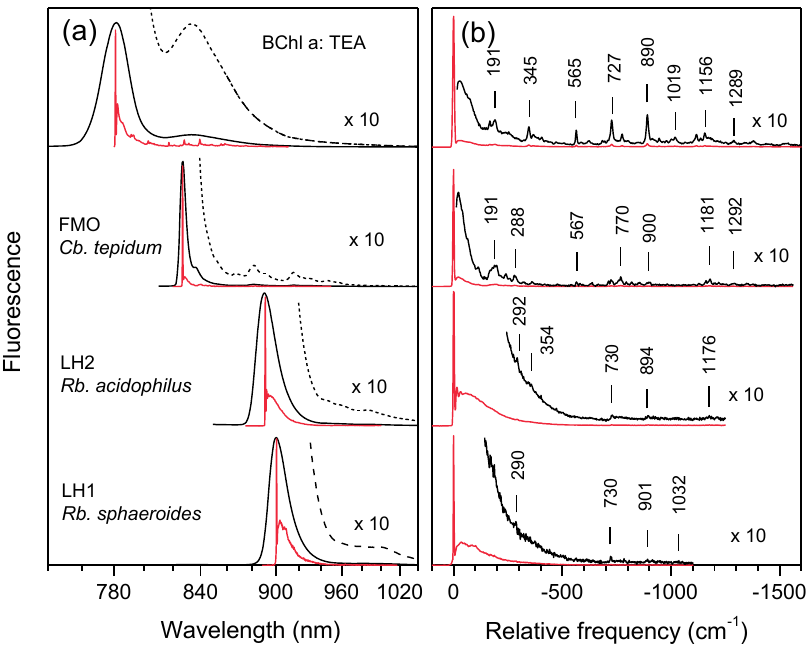
Fig. 11 . (a) Comparison of the low-resolution (black line) and high-resolution (red line) fluorescence spectra of BChl-a in frozen solution of TEA and in three different light-harvesting complexes as indicated. The peak-normalized spectra recorded at 4.5 K are presented on the reciprocal wavelength (energy) scale. Shown with dashed lines are the 10-fold amplified tails of the low-resolution spectra. (b) Peak-normalized Δ FLN spectra of the same samples on the relative wavenumber scale; vertical lines label selected vibrational mode frequencies in the ground electronic state. Adapted with permission from [142]. Copyright 2014 AIP